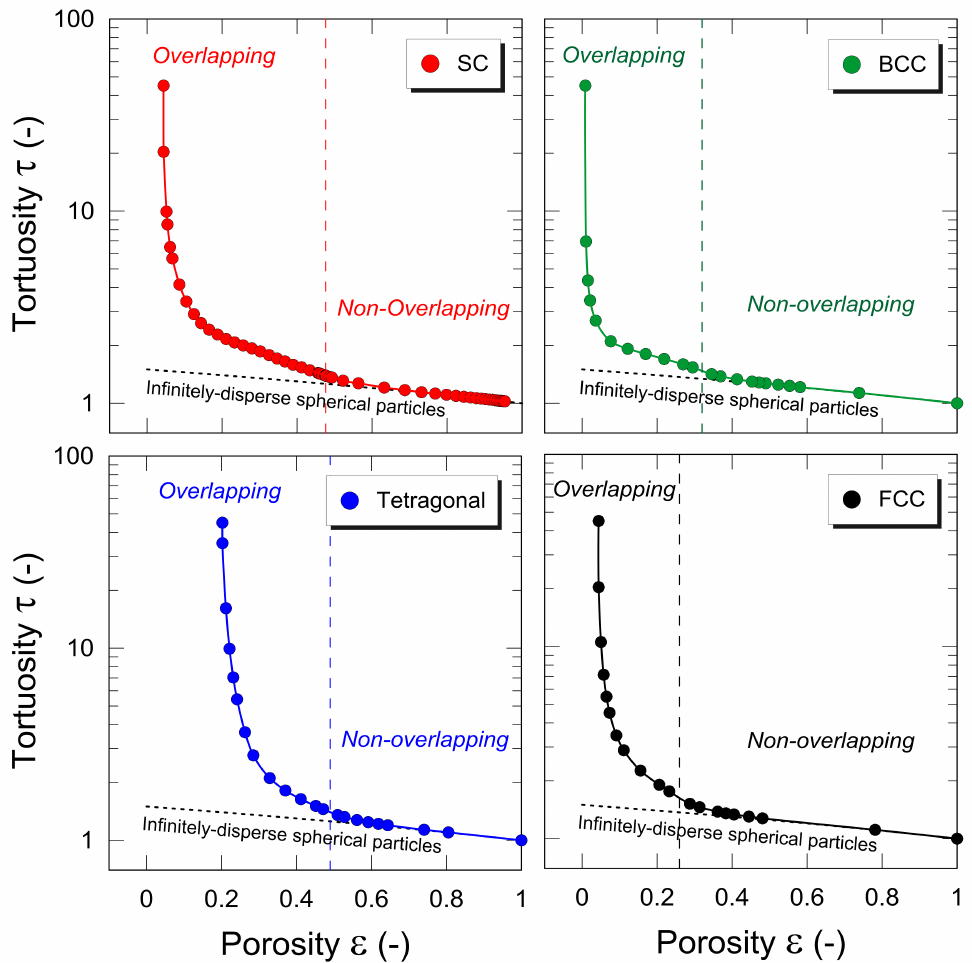
Figure 11. Tortuosity τ as a function of porosity ε for the considered structures. The dashed line in each plot refers to the model developed by Neale and Nader (1973). Overlapping and Non-overlapping domains are distinguished in each